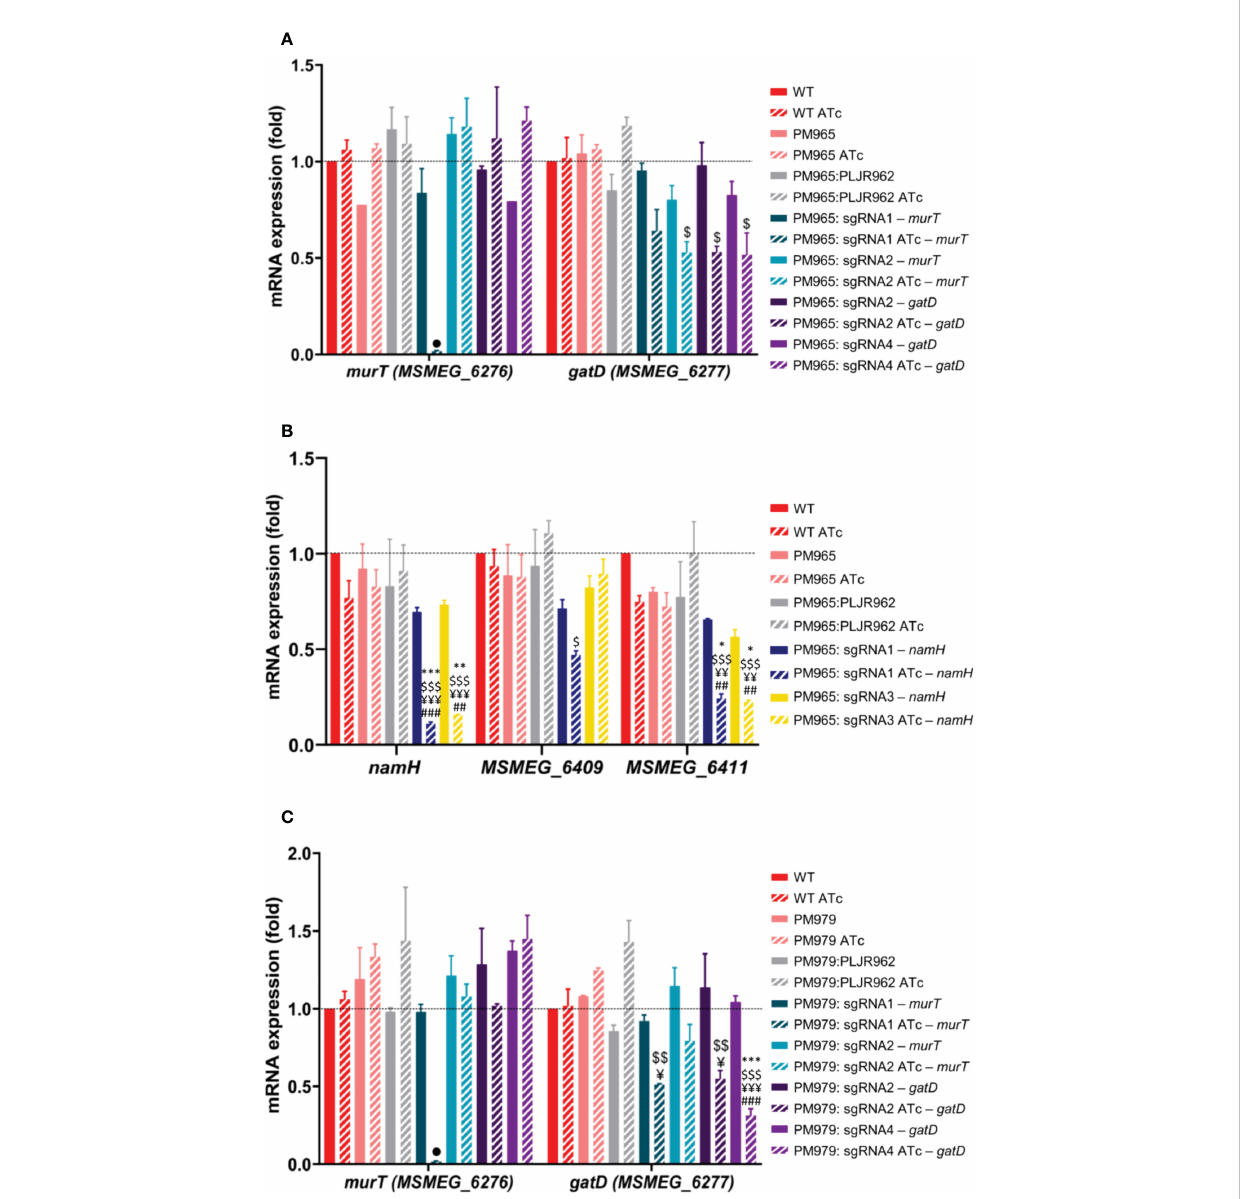
FIGURE 5 Results of qRT-PCR assays for the double and triple mutants (n=2): (A, B) Double mutants: (A) murT (blue) and gatD (purple) knockdown mutants constructed in PM965; (B) namH knockdown mutants constructed in PM965; (C) Triple mutants: murT (blue) and gatD (purple) knockdown mutants constructed in PM979. The graph shows the mean of the relative mRNA expression of genes of interest normalized to sigA , at 6 hours post-induction, with (stripped bars) and without (smooth bars) ATc. Dashed lines show the WT as calibrator. Error bars show the standard error of the mean. Multiple comparisons were made using one-way ANOVA, * P < 0.05; ** P < 0.01; *** P < 0.001. Signi fi cant differences are indicated with symbols: # comparing to control M. smegmatis WT ATc, ¥ comparing to controls PM965 ATc or PM979 ATc, $ comparing to PM965:PLJR962 ATc or PM979:PLJR962 ATc, * comparing to the respective uninduced strain. The (cid:129) symbol indicates a highly signi fi cant difference ( P < 0.0001) from all